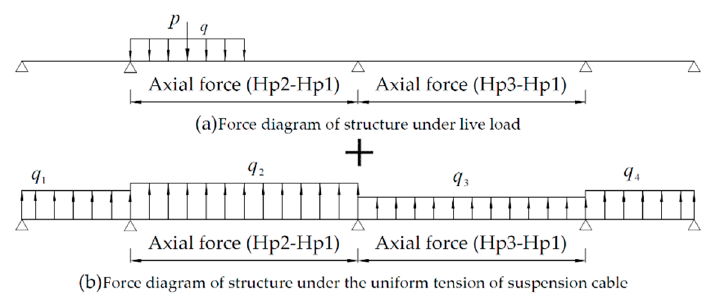
Figure 3. Load superposition calculation. q 1 , q 2 , q 3 and q 4 = the uniform tension of suspension cable of each span.